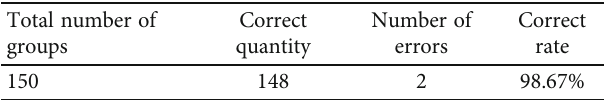
Table 3: Accuracy of weightlessness feature extraction and